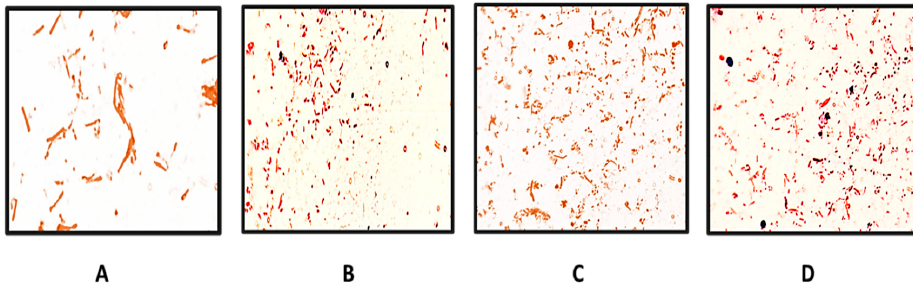
Figure 7. Germination of Bacillus coagulans at 100 × magnification after ( A ) 2 h, ( B ) 4 h, ( C ) 6 h, and ( D ) 24 h.